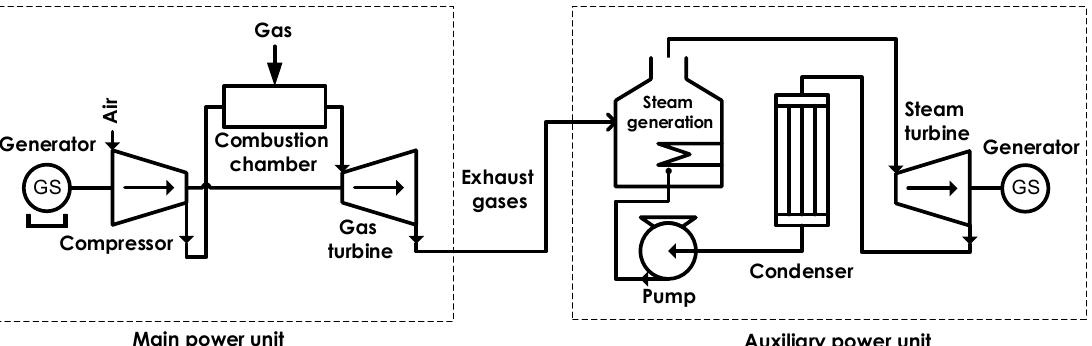
Figure 2. Operational scheme of the investigated binary energy system combining main and auxiliary power units [45].